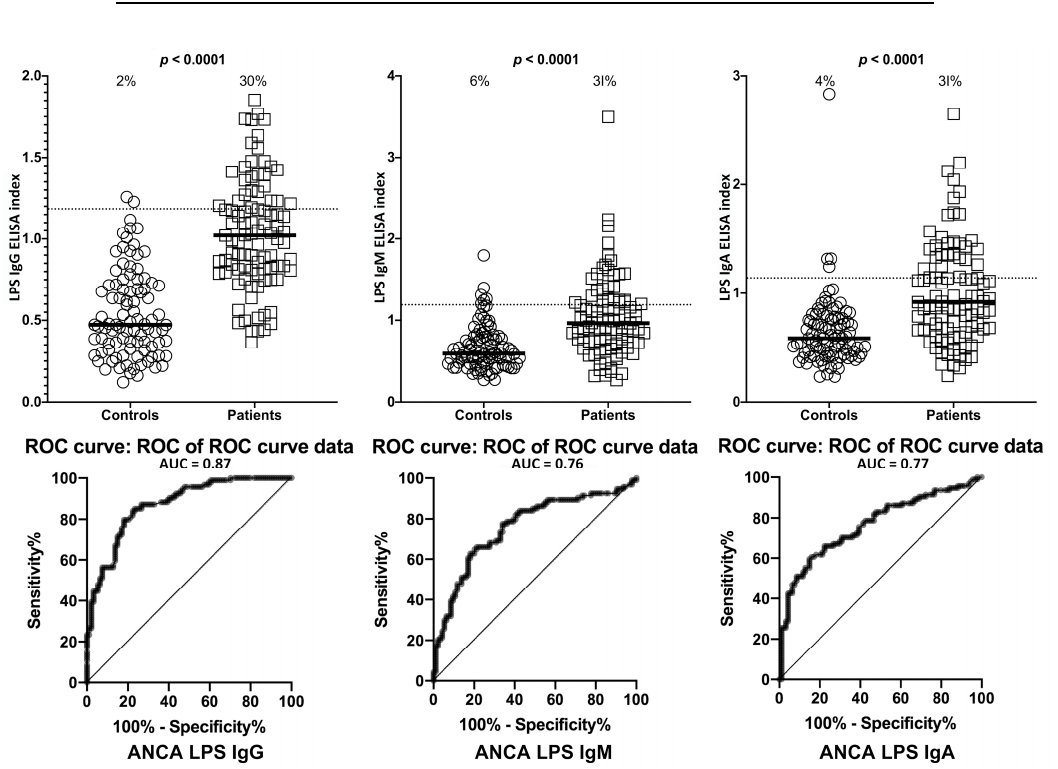
Figure 6. Percentage of elevation of IgG, IgM, and IgA antibodies against lipopolysaccharides (LPS) in 94 patients positive for ANCA and in 94 healthy controls. Dotted lines indicate the cutoff for positivity used in each assay, as calculated by ROC analysis. The percentage of elevation is indicated on top of each distribution, while bars indicate the corresponding median. The AUC for LPS IgG was 0.87, 0.76 for LPS IgM, and 0.77 for LPS IgA.